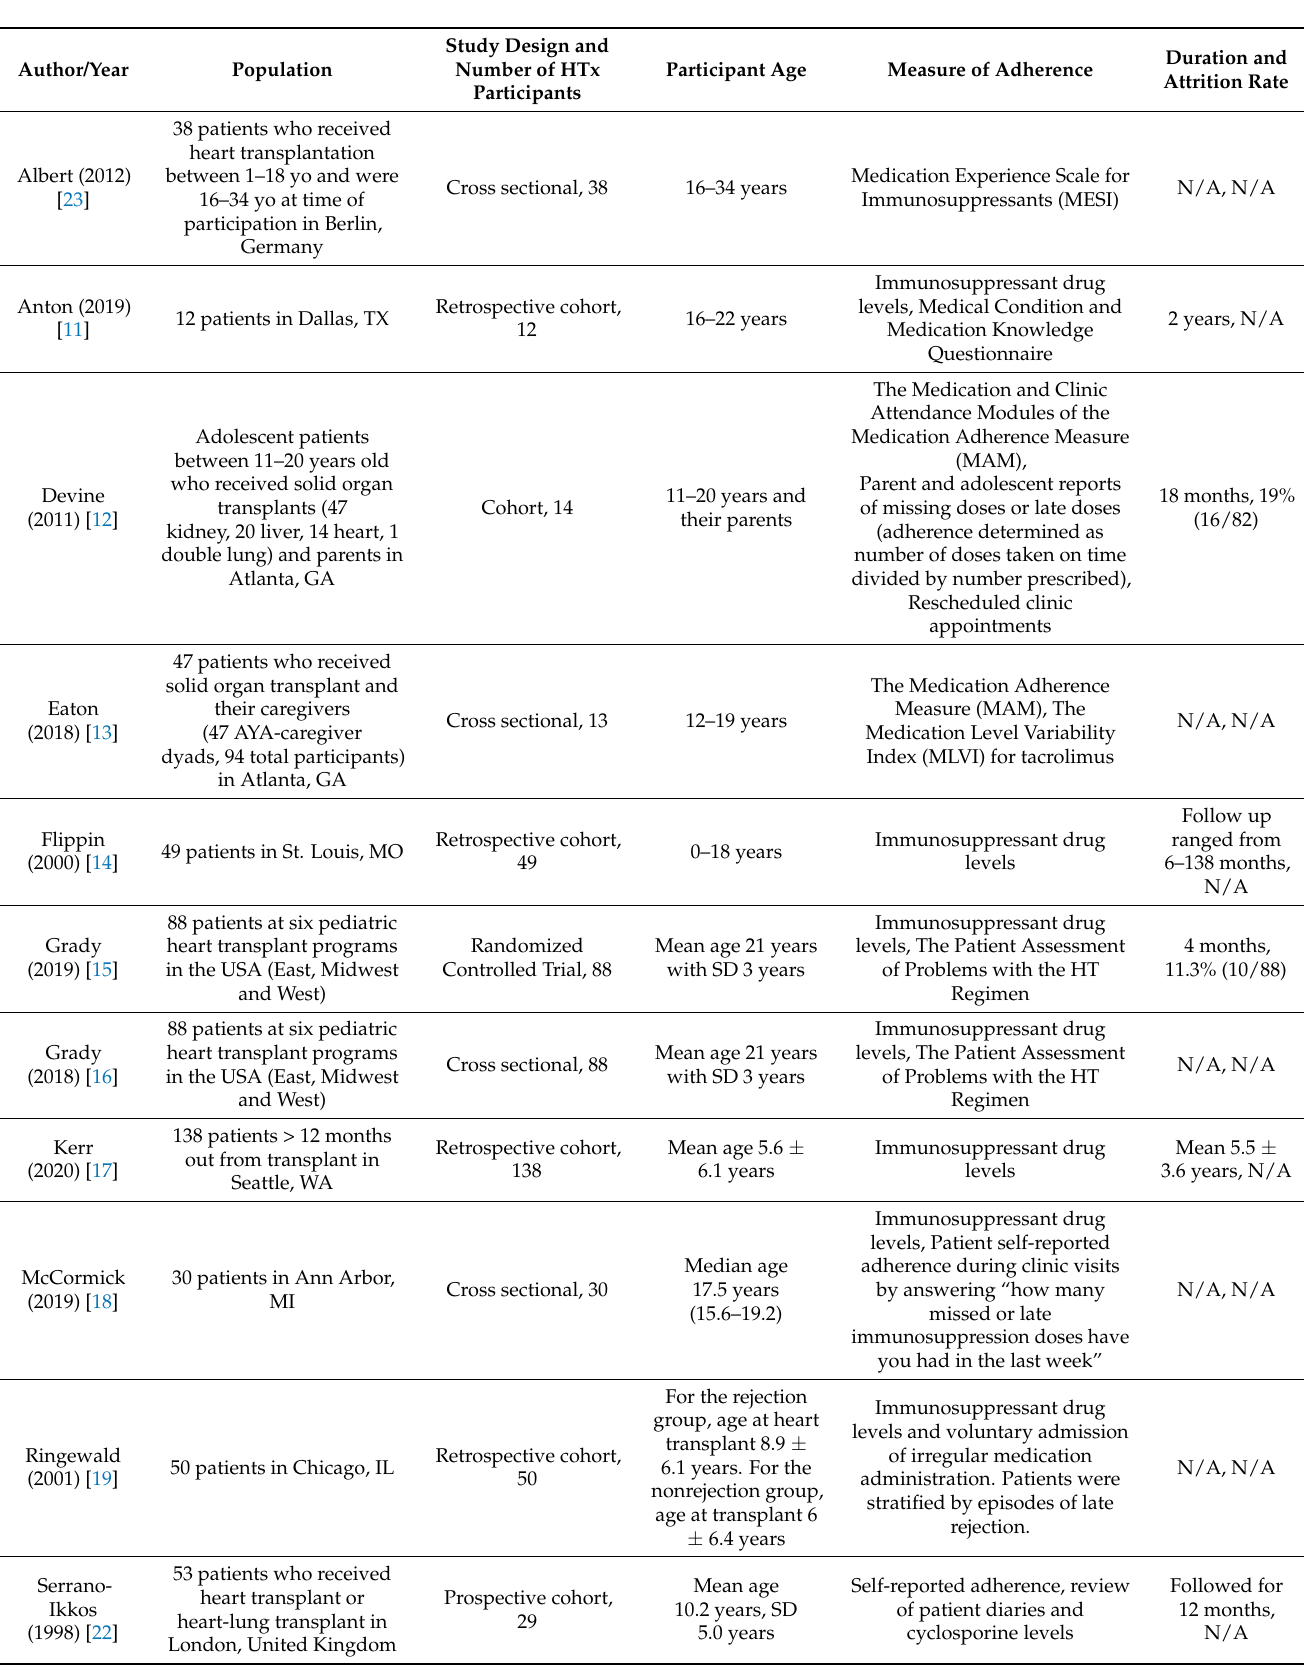
Table 1. Characteristics of all included